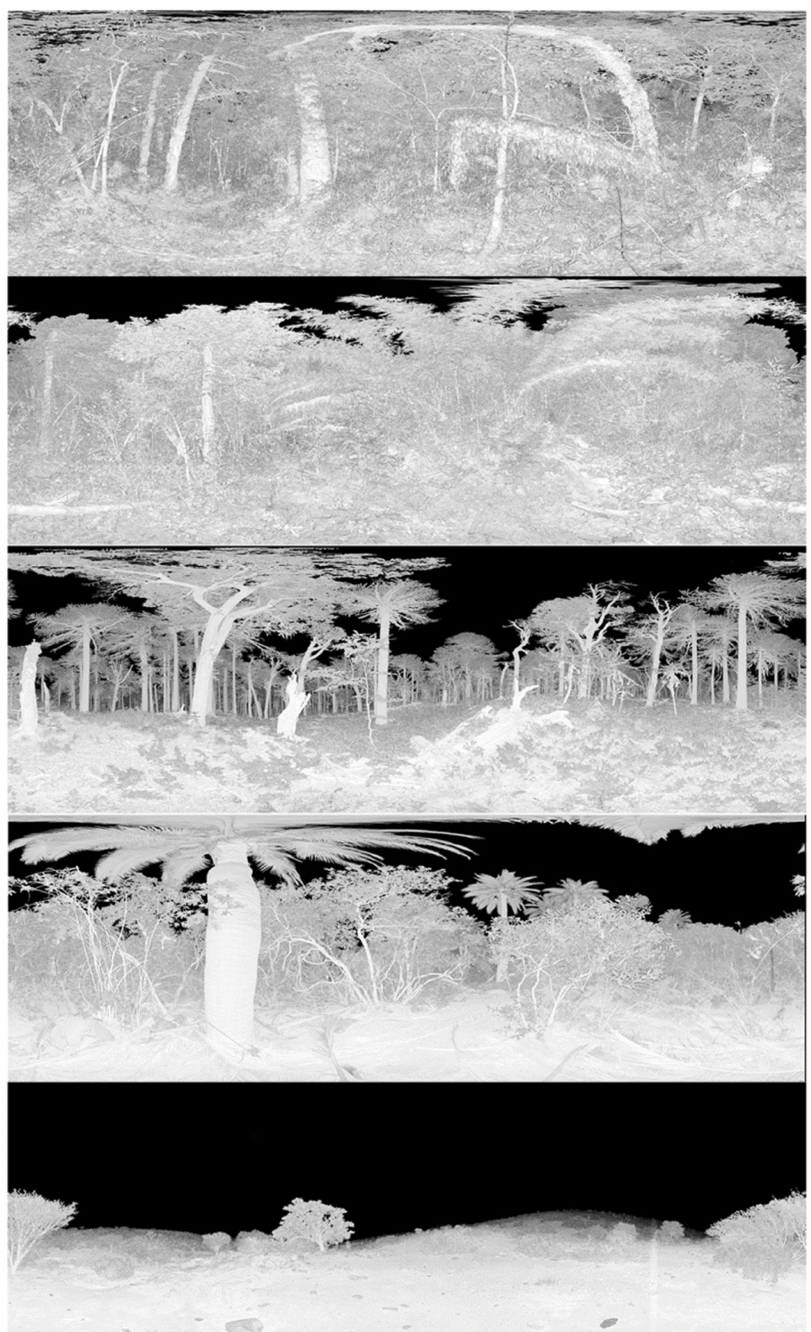
Figure 3. Exemplary 2D representation of the 3D data derived from the scans for each study site (panoramic views from single scans). From top to bottom: Tantauco, San P. d. Tregua, Villarica, La Campana and Las